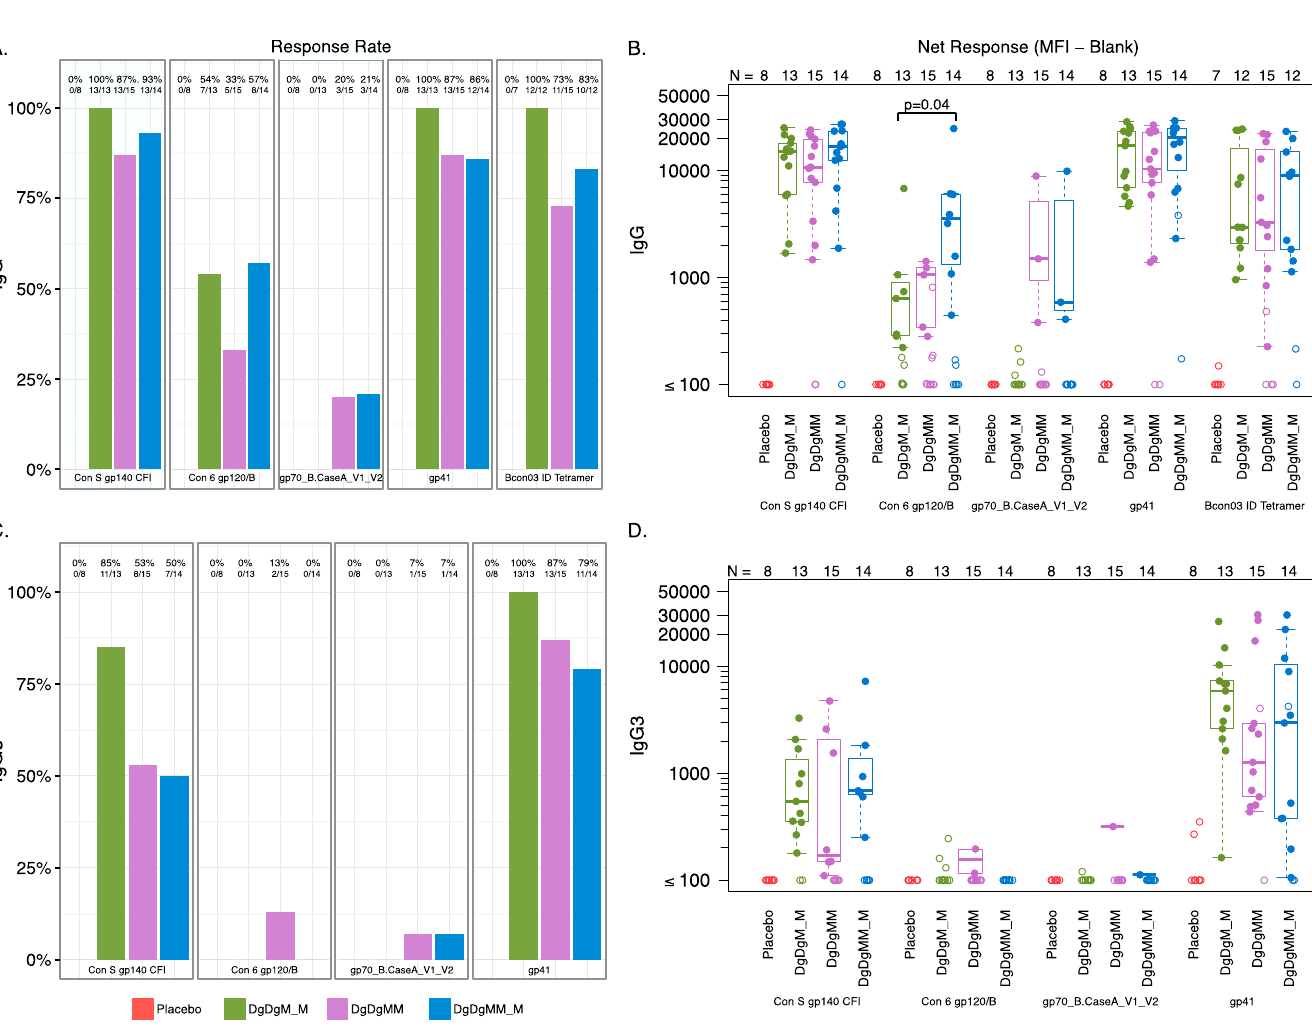
Fig 3. Peak IgG and IgG3 responserates and magnitudes. (A) Peak IgG bindingantibodyresponserates. (B) Peak IgG bindingresponse magnitudes. (C) Peak IgG3 bindingantibodyresponserates. (D) Peak IgG3 bindingantibodyresponsemagnitudes.Responses are to individualantigensat two weeks after the 2nd and 3rd MVA or placeboin the Placebo,DgDgM_Mand DgDgMM_M groups. DgDgM_Mrefers to immuneresponsesafter the last MVA in the DgDgM_Mgroup; DgDgMMand DgDgMM_M refer to immuneresponsesafter the 2nd and 3rd MVA in DgDgMM_M group, respectively. Shown are total IgG bindingantibodyresponse rates to HIV-1 Env gp140(ConS gp140), HIV-1 Env gp120(Con 6 gp120B), the V1V2 loop, gp41and the gp41 immunodominant